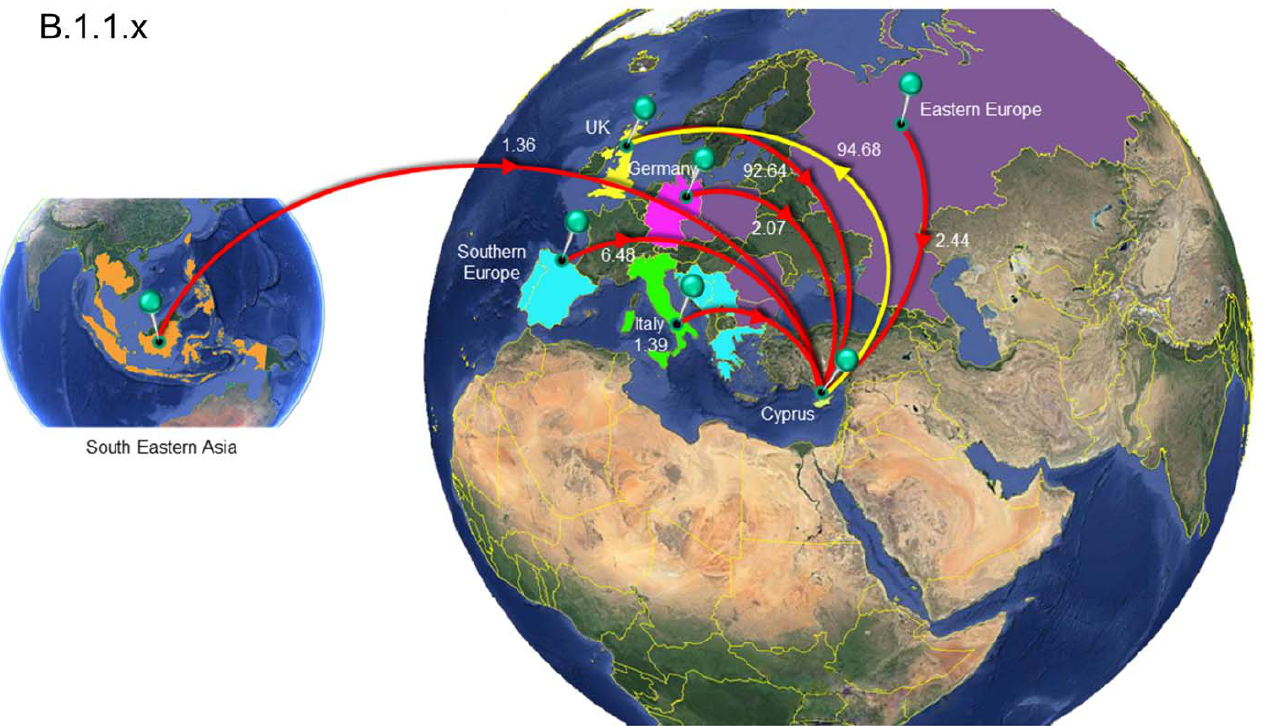
Figure 8. Map of SARS-CoV-2 B.1.1.x clade group transmission between Cyprus and other countries. The geographic origins of SARS-CoV-2 B.basal imported into Cyprus based on the statistical phylogeographic analysis are shown as red lines, and exports from Cyprus to other countries are shown as yellow lines. Countries and groups of countries acting as “sources” or “sinks” for SARS-CoV-2 B.1.1.x transmission are highlighted and labeled, and the average number of migration events is indicated. The highlighted area of Eastern Europe consists of Bulgaria, Romania, the Czech Republic, Poland and Russia, and the highlighted area of southern Europe consists of Bosnia and Herzegovina, Croatia, Greece, Montenegro, Serbia, Portugal and Spain. The highlighted area of southeastern Asia consists of Cambodia, the Philippines, Taiwan, Thailand, Indonesia, Singapore and Malaysia. Map images courtesy of Google Earth Pro 7.3.2.5776 (14 December 2015). Center: Global view centered on Europe. 36°16 ′ 38.78 ″ N 36°07 ′ 29.71 ″ E, Eye alt 7949.12 km. US Dept. of State Geographer, DATA SIO, NOAA, U.S. Navy, NGA, GEBCO. Image Landsat/Copernicus. 2018 © Google. Left: Southeastern Asia Region: 6°16 ′ 52.33 ″ N 113°55 ′ 29.68 ″ E -18 m, Eye alt 8880.55 km, Image Landsat/Copernicus, US Dept. of State Geographer, Data SIO, NOAA, U.S. Navy, NGA, GEBCO, © 2021 Google. https://www.google.com/earth/versions/#earth-pro (accessed